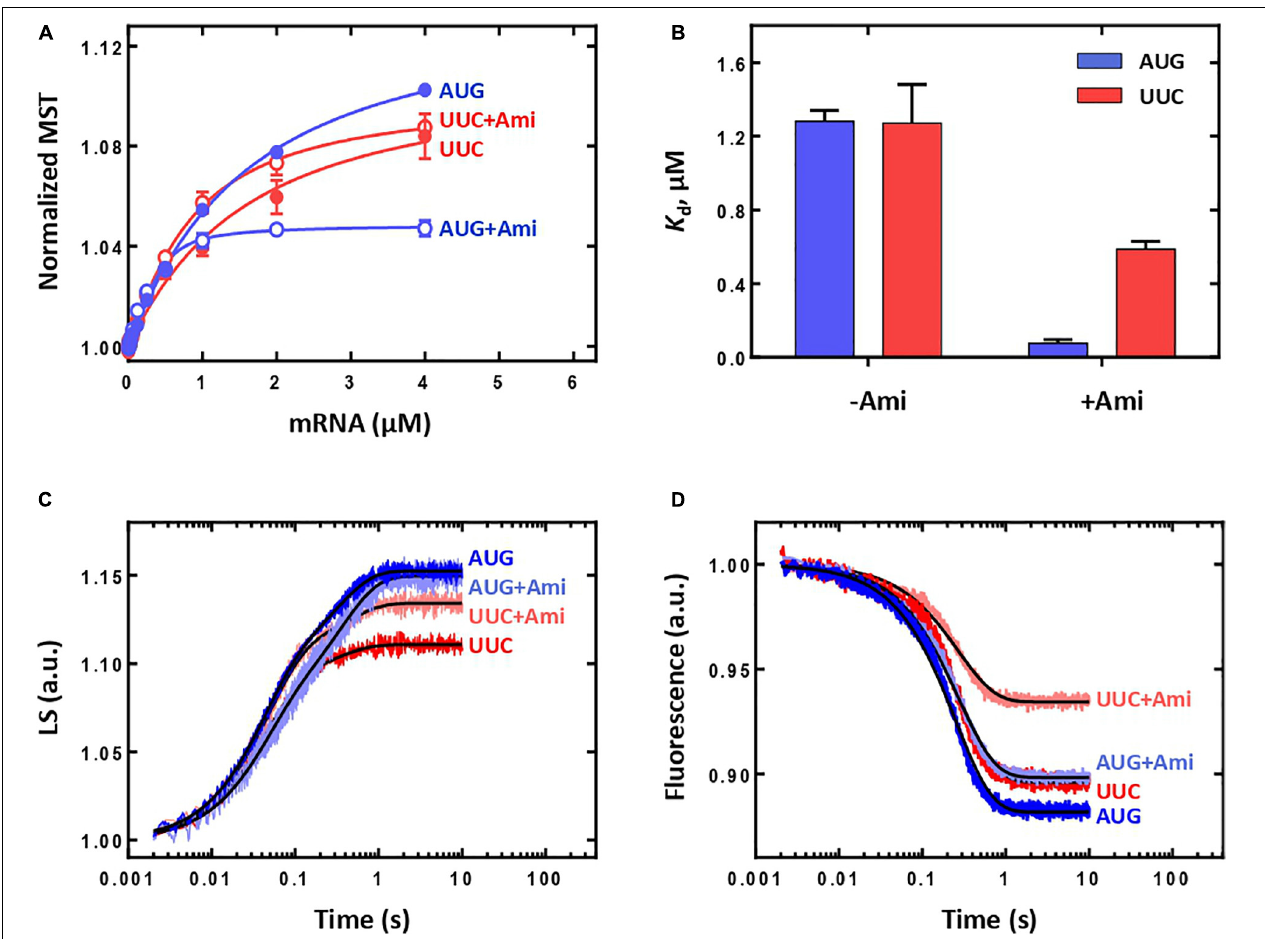
FIGURE 3 | The influence of Ami on the initiation in a system lacking IF3. (A) Titration of the 30S IC formation in the absence of IF3 with mRNA containing either AUG or UUC start codon. (B) Dissociation constants ( K d ) calculated from (A) . (C) Association of the 50S subunit (0.3 µ M) with the 30S IC in the absence of IF3 (0.1 µ M) monitored by light scattering. (D) Association of the 50S subunit (0.3 µ M) with the 30S IC in the absence of IF3 (0.1 µ M) monitored by fluorescent signal from the BPY reporter of the initiator BPY-Met-tRNA fMet